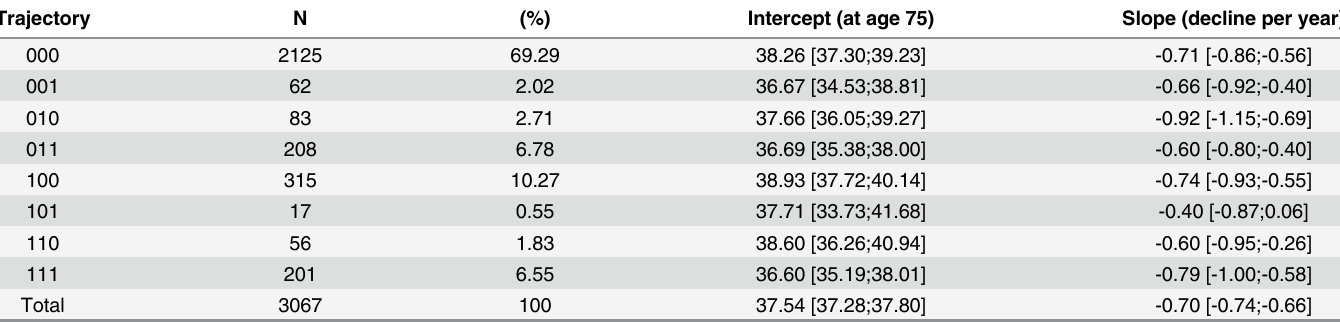
Note : 95% con fi dence interval in brackets. Trajectories are described by 1 for exposure to low OP, and 0 for no exposure. Averaged across countries and predicted for the level of the cohorts 1931 – 1933.